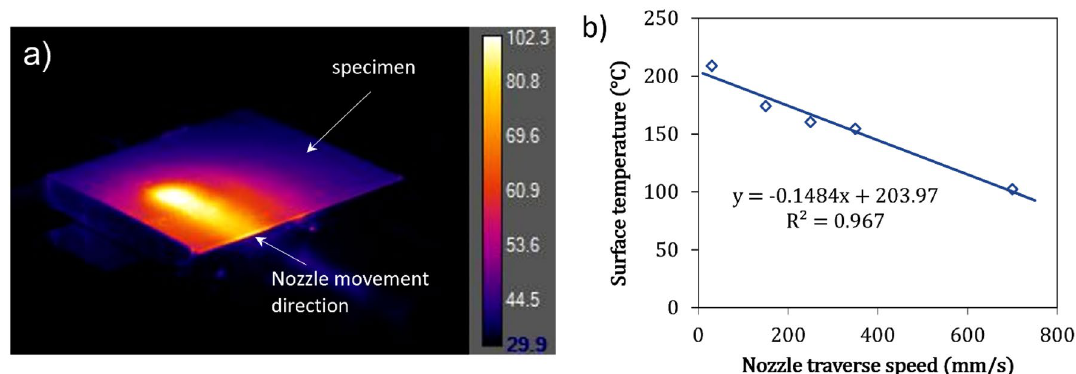
Figure 3. ( a ) Contour of temperature distribution (°C) during cold spraying the PEEK substrate with a linear scan pattern and a scanning step of 1 mm at a nozzle speed of 0.7 m / s with no powder ( b ) induced surface temperature over the spray spot as a function of nozzle traverse